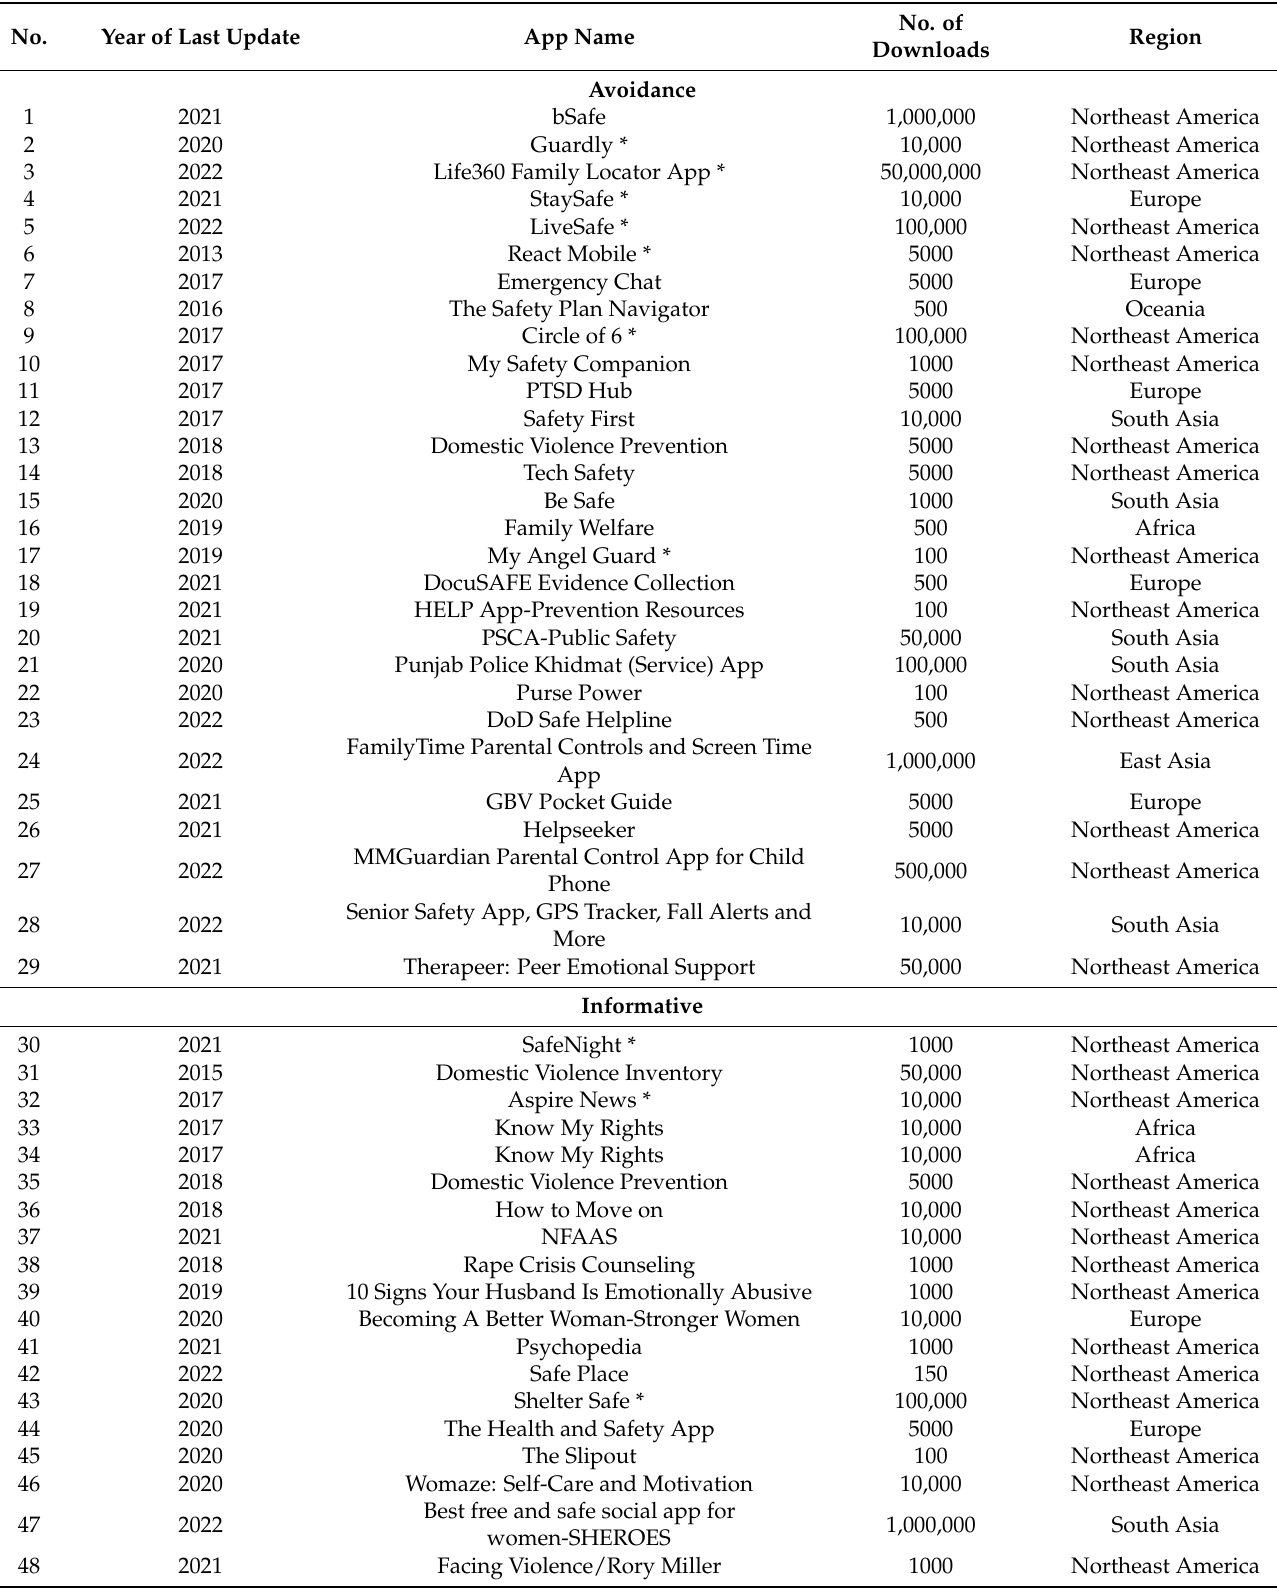
Table A1. List of 136 domestic violence apps systematically reviewed (see Figure